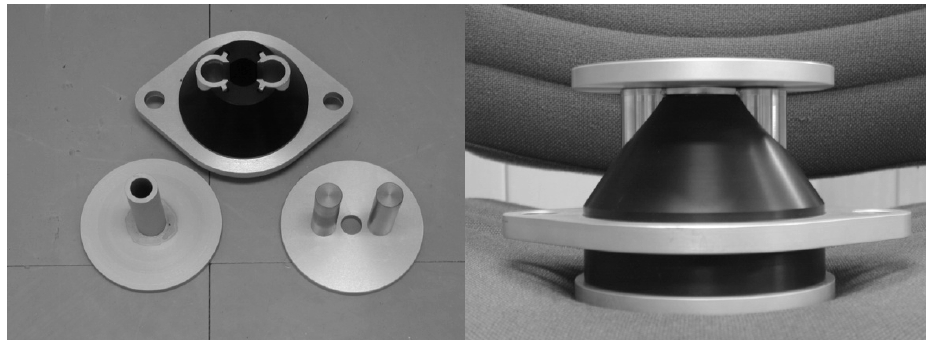
Fig. 5. Photograph of the manufactured hybrid